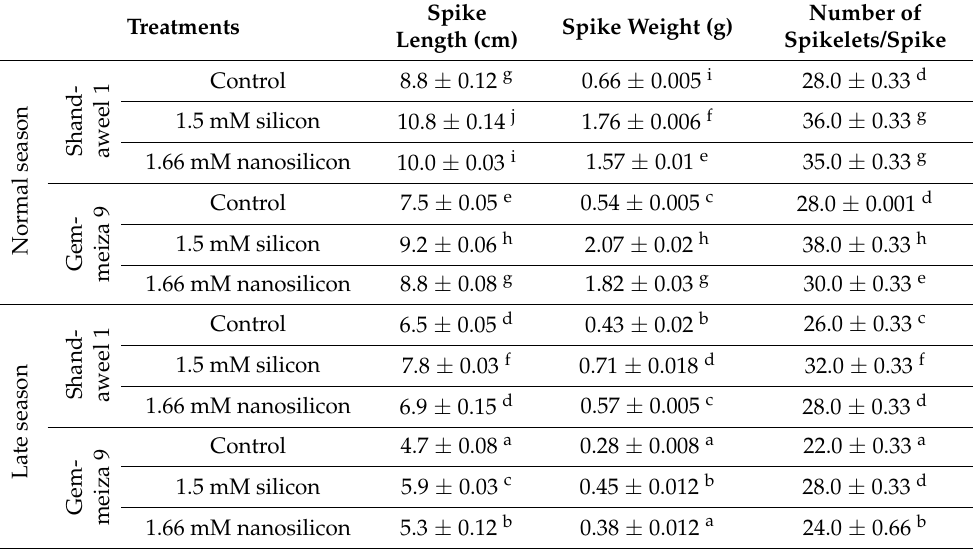
Table 1. Effects of silicon and nanosilicon on yield components (spike length, spike weight, number of spikelets per spike) of two wheat cv. Shandaweel 1 and cv. Gemmeiza 9 at normal and late seasons. Each value is the main of 10 different replicates ± SE.